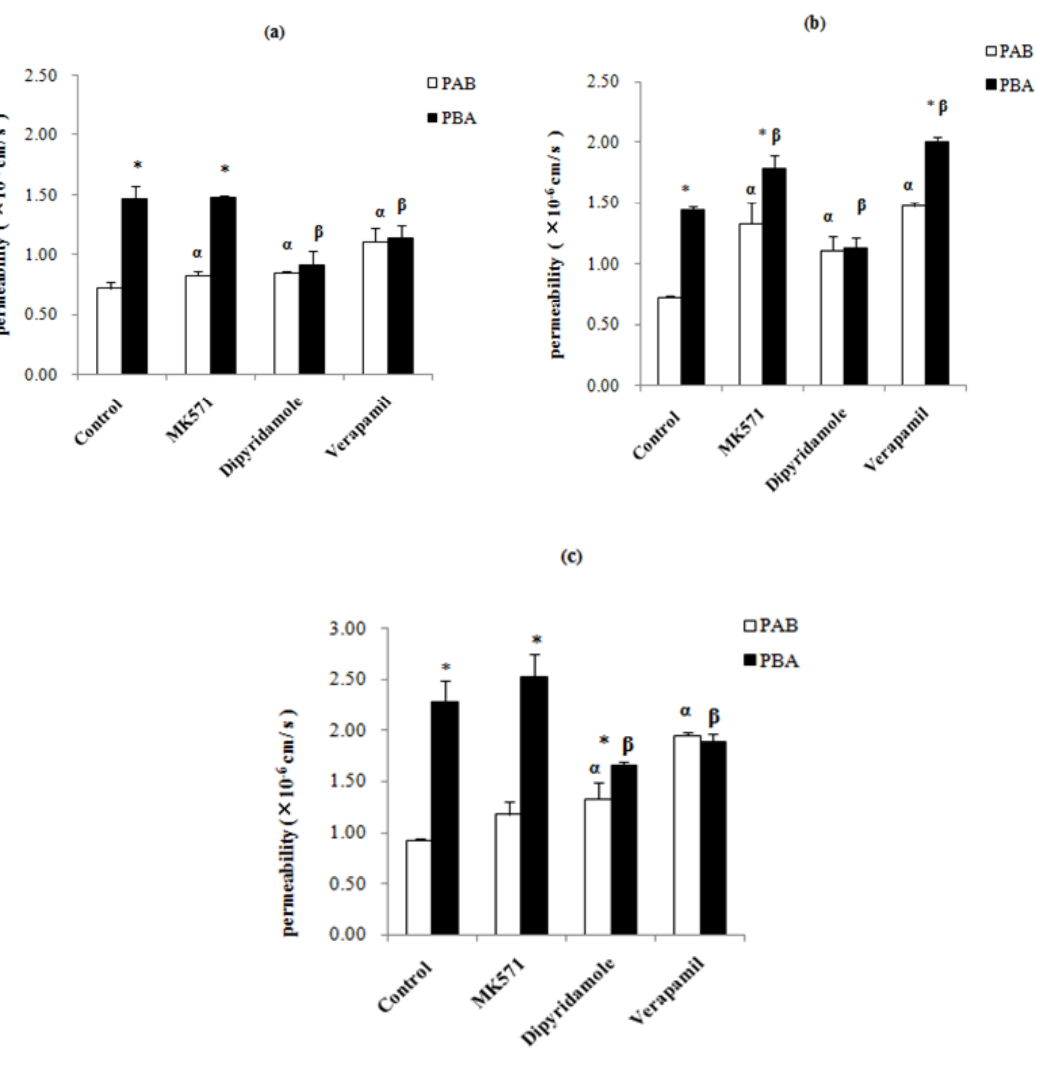
Figure 4. Effects of various potential inhibitors on permeabilities of epimedins A (20 μ